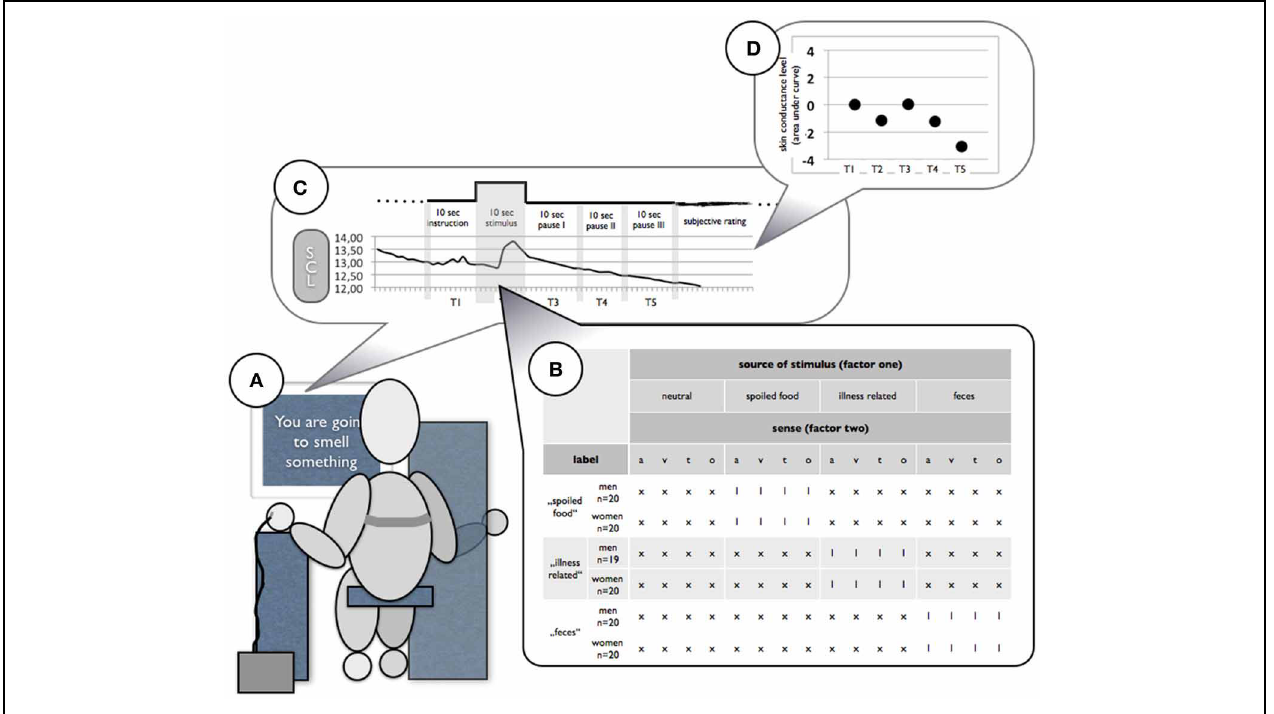
FIGURE 1 | Schematic visualization of the experimental setup. (A) Participants sat in front of a monitor where instructions and pictures were presented. Auditory stimuli were presented via head set, olfactory were presented in opaque brown glass jars which were placed under the participant’s nose and tactile stimuli were placed in the participant’s supine